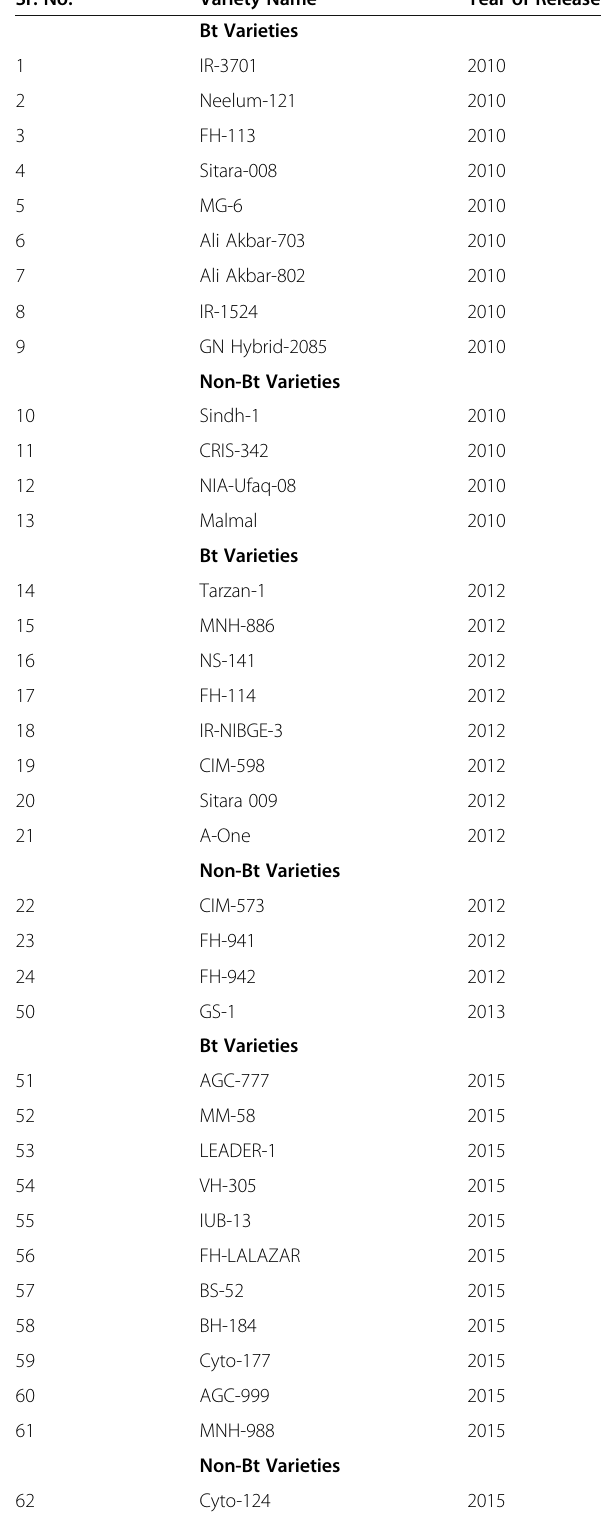
Table 2 Approved Bt and non-Bt cotton varieties in Pakistan from 2010 to 2019 Sr. No.